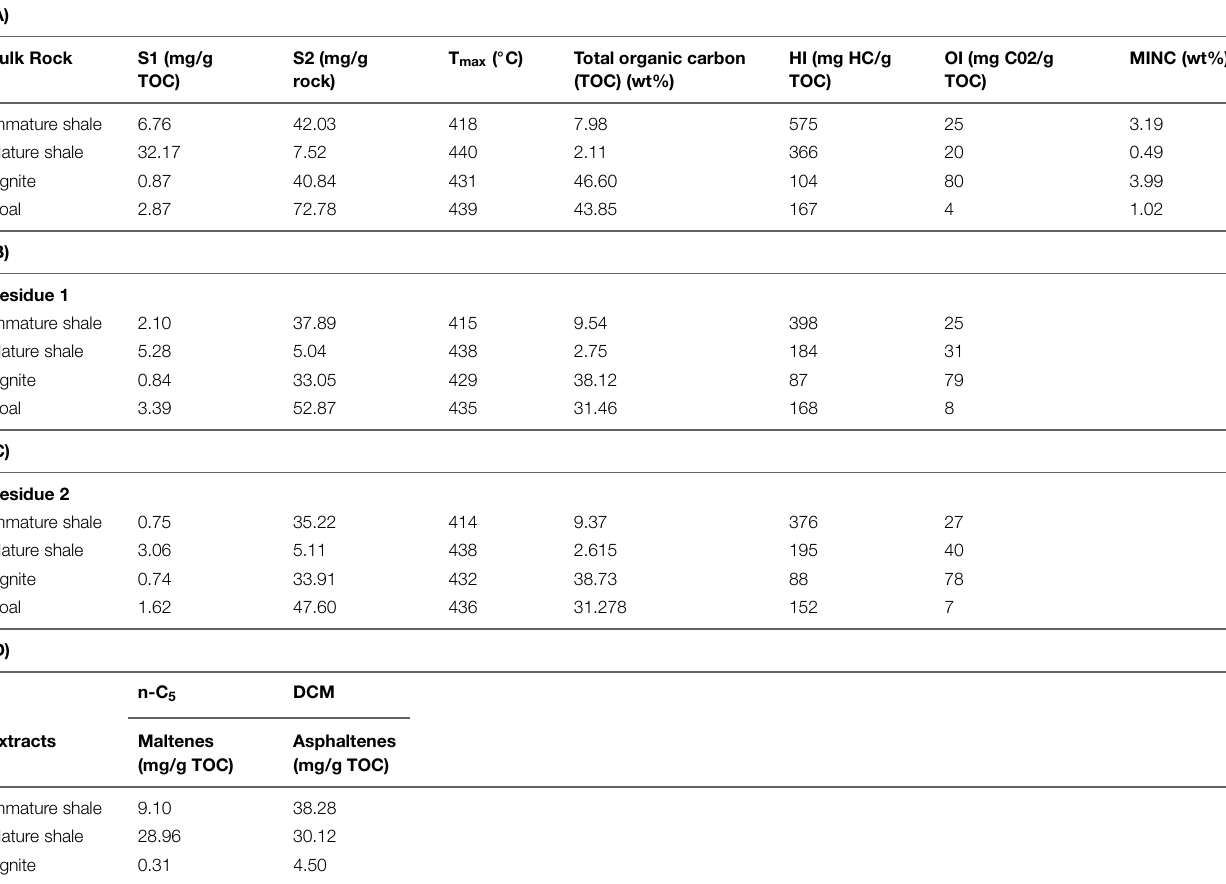
TABLE 1 | Main geochemical parameters obtained by Rock-Eval 6 pyrolysis on the four bulk rocks (A) and their residues after solvent extractions, (B) Residue 1: after n-C 5 extraction, (C) Residue 2: after n-C 5 and dichloromethane (DCM) extraction, (D) Quantifications of the soluble fractions extracted from the bulk rocks